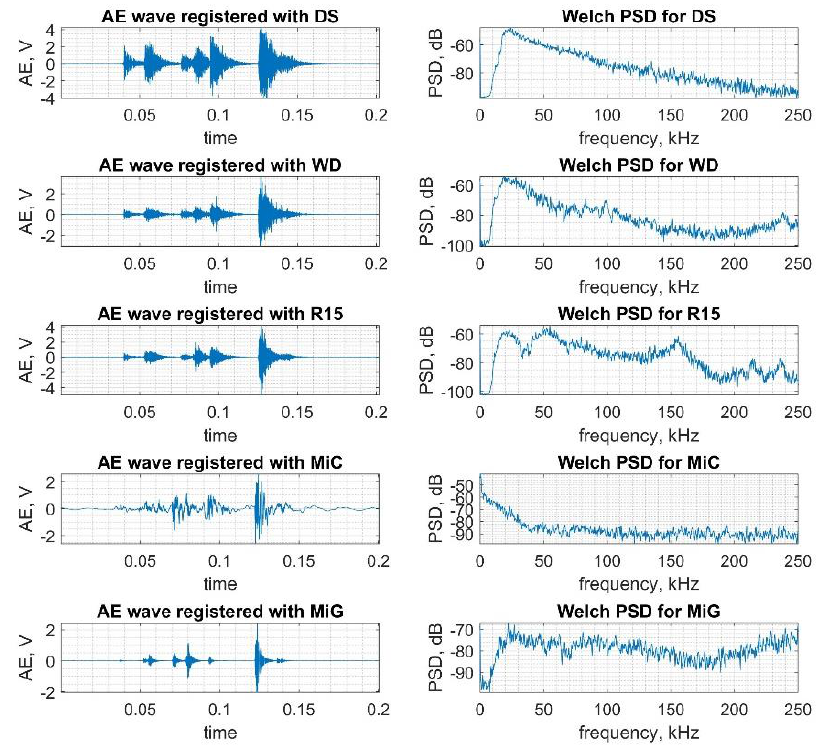
Figure 3. Example waveforms and corresponding Welch power spectrum density (PSD) of class C1 signals registered with the considered sensors. Table 1. Number of samples used for each sensor related to the class considered. Class no